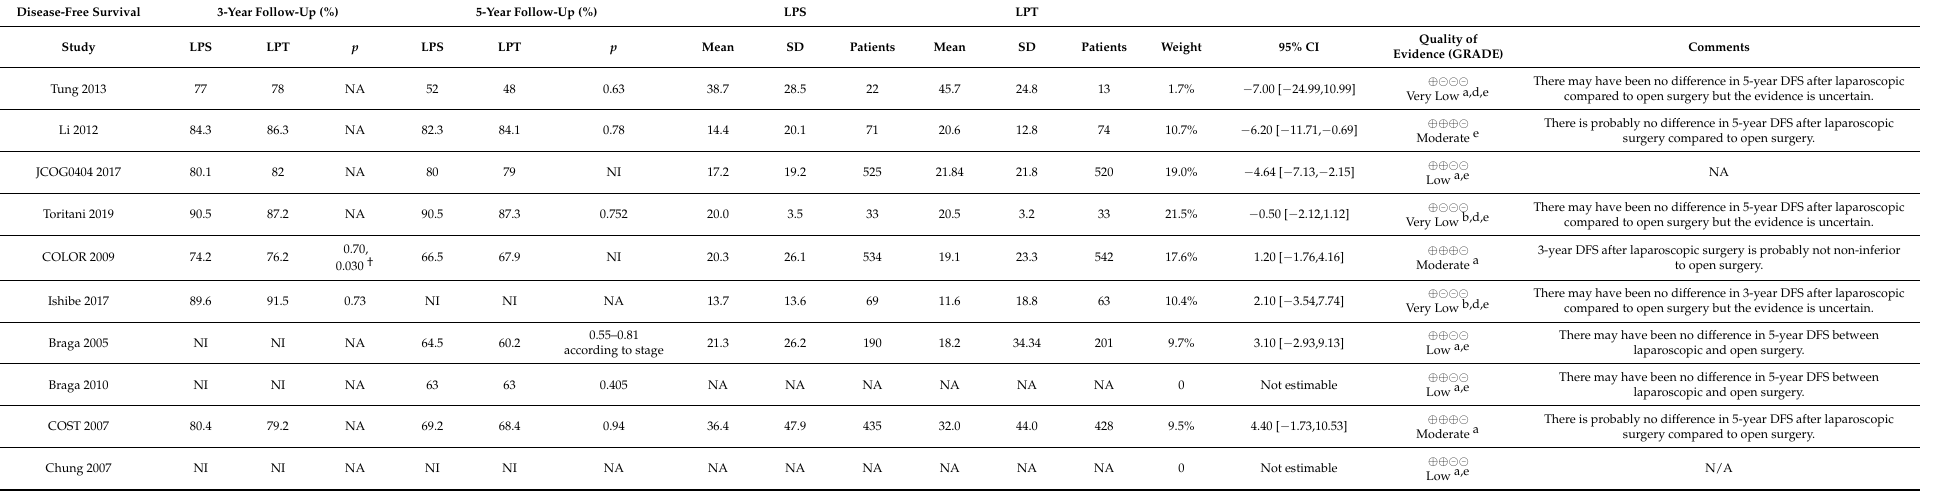
Table 4. Summary of disease-free survival at 3 and 5 years and quality of evidence. Data extracted from Kaplan–Meier curves using GetData Graph Digitizer. Excluding patients with stage IV